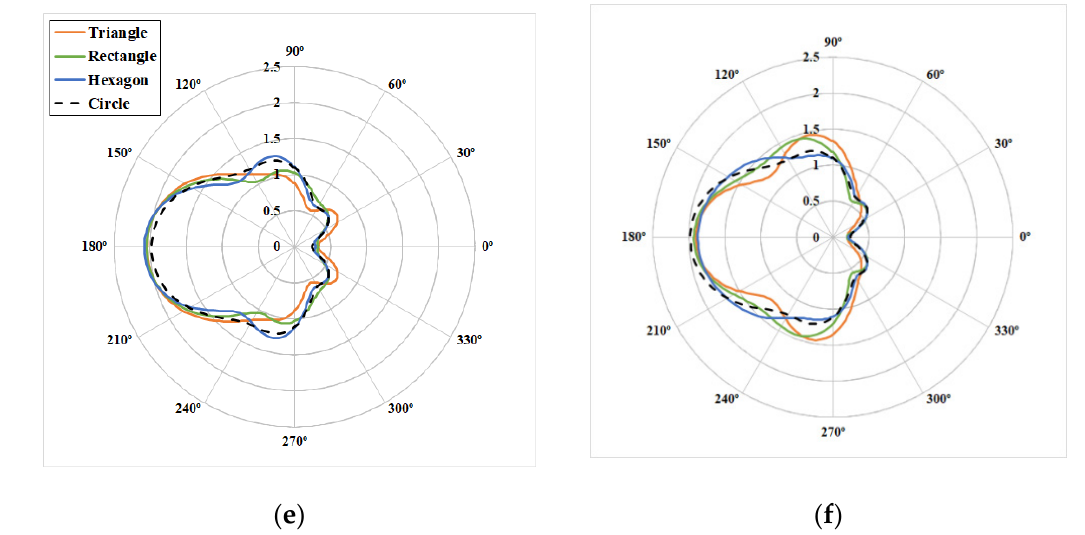
Figure 11. Wave profiles for triangular, square, hexagonal, and circular platforms ( T = 10 s): ( a ) wave profiles in the sea side for Case 1; ( b ) wave profiles in the sea side for Case 2; ( c ) wave profiles in the lee side for Case 1; ( d ) wave profiles in the lee side for Case 2; ( e ) wave runup for Case 1; and ( f ) wave runup for Case 2.